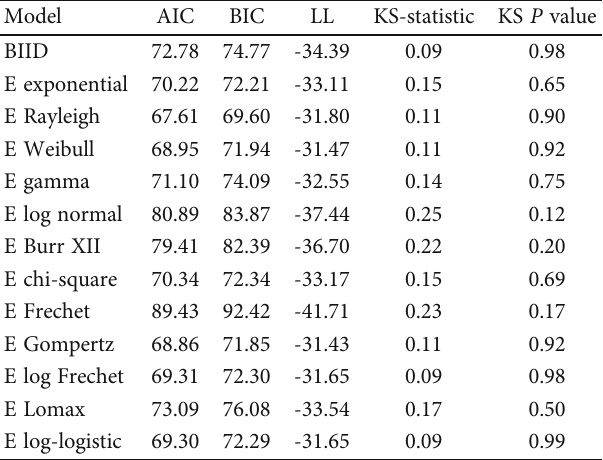
AIC: Akaike information criteria; BIC: Bayesian information criteria; LL: log-likelihood; KS: Kolmogorov-Smirnov.